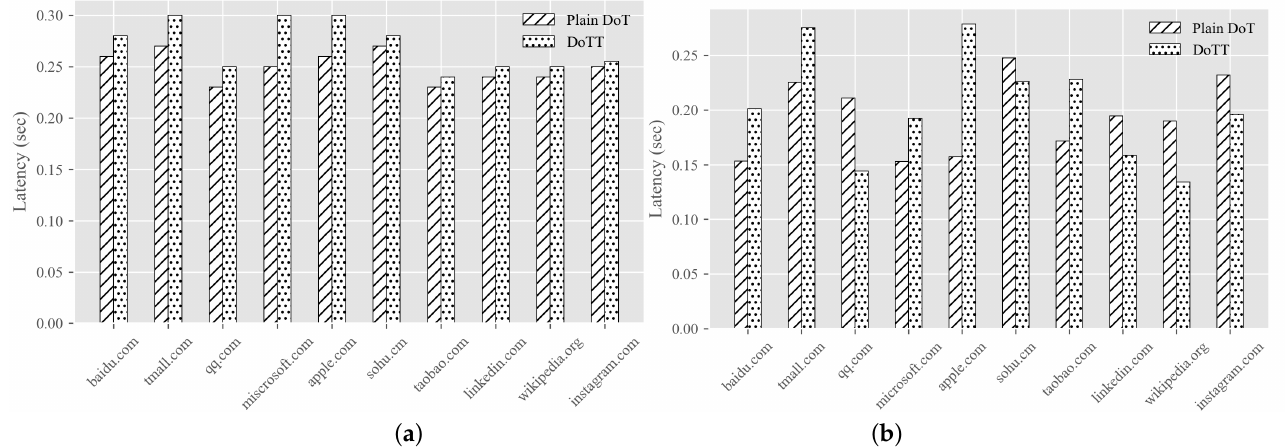
Figure 5. Performance evaluation of establishing TLS connections between DoT and DoTT. ( a ) Es- tablishing TLS connections for each new request, and ( b ) reusing the existing connections for new